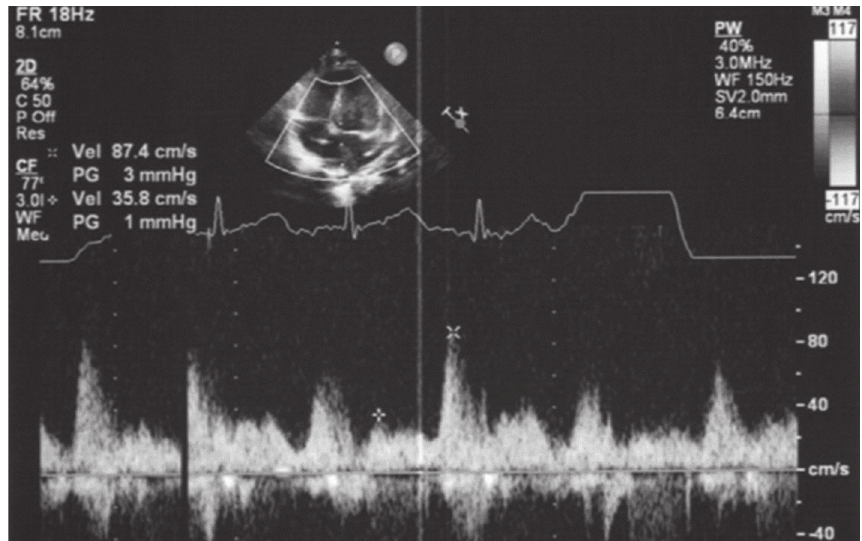
Figure 4: Echocardiography at the age of 4 months in the outpatient clinic. Inflow of blood from the common chamber to the left atrium can be observed. The flow pattern is pulsatile, and no anastomotic stenosis is observed. The cardiac contractility is good, and no other abnormal findings, including pulmonary vein stenosis, are